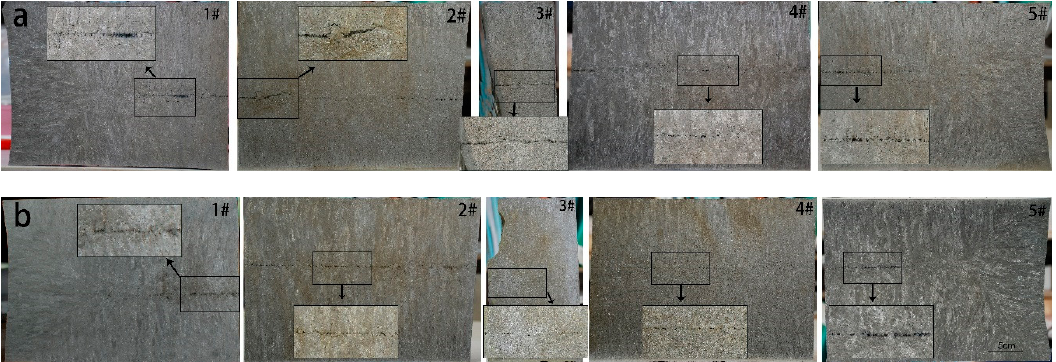
Figure 2. Images of the macro-etched slab: ( a ) Slab A; ( b ) slab B. Table 1. Centerline segregation degree rated by the Mannesmann rating method (class).